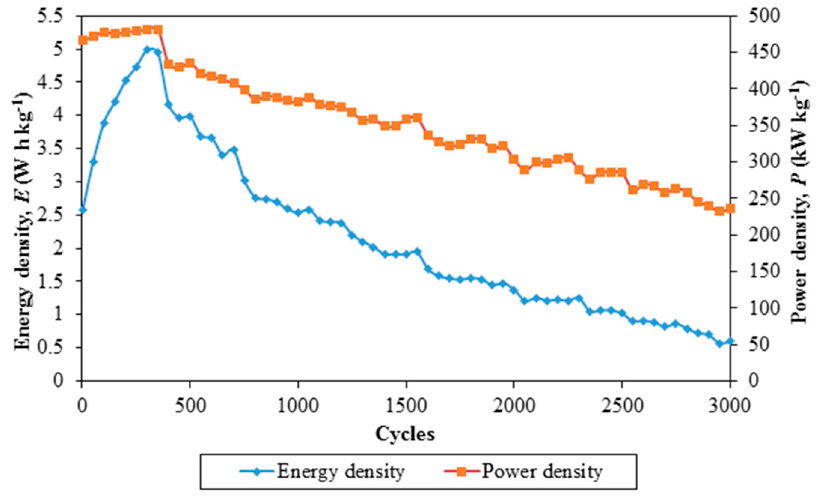
Figure 7. Energy density and power density of Ti 3-based EDLC over 3000 cycles of charging and discharging.